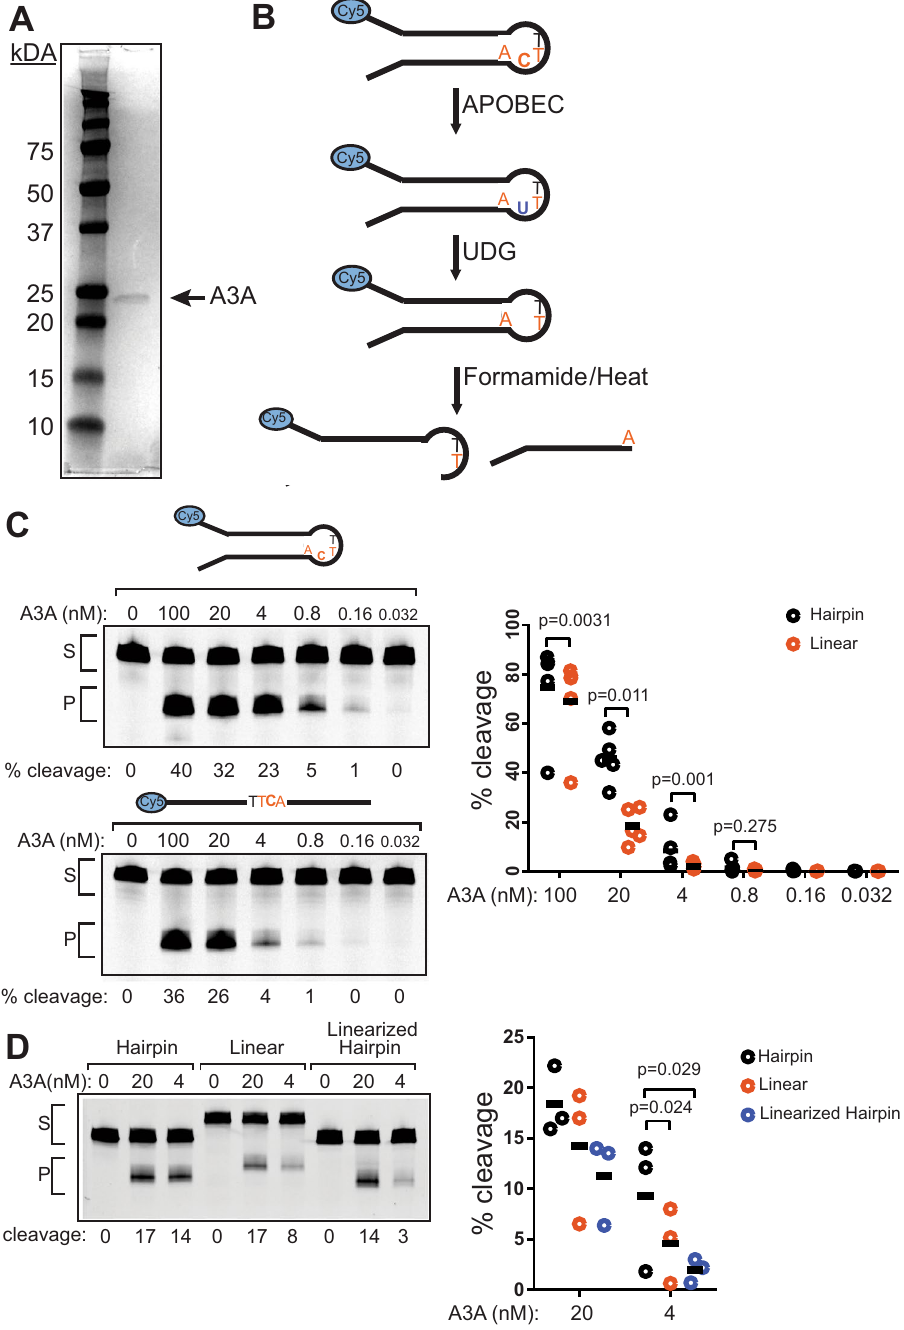
Figure 1. APOBEC3A prefers to deaminate hairpins over linear ssDNA. ( A ) Coomassie stained SDS-PAGE gel showing the purity of C-terminally Strep-tagged A3A (23 kDa) overexpressed in and purified from HEK293T cells. ( B ) Schematic of the in vitro deaminase assay. ( C ) Representative gel images of the activity of decreasing concentrations of purified A3A incubated with 250 nM hairpin and linear substrates in vitro for 30 min at 37 °C in the presence of uracil DNA glycosylase. S denotes substrate band; P denotes the product band. Quantification of 5 replicate experiments comparing A3A activity on hairpin and linear substrates. Horizontal bars indicate mean values. P-values were determined by Ratio paired t-tests. ( D ) 20 nM A3A, 4 nM A3A or no A3A was incubated with 250 nM hairpin or linear substrates. Reactions were performed and denoted as in 1C. Shown is a representative gel image and the quantification of 3 independent experimental replicates (horizontal bars represent mean values for each condition). P-values were determined as in ( C ). Full-length gel images for 1C and 1D are presented in Fig.